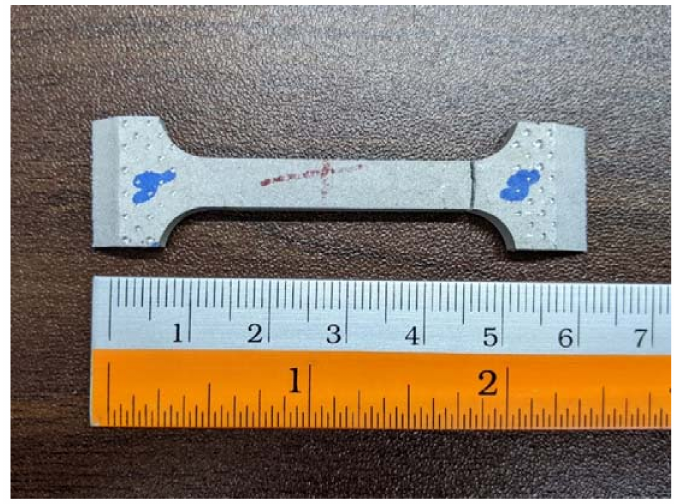
Figure 3. An example of the tensile test specimen tested in this work. The photo was taken after testing to show the crack in the specimen.